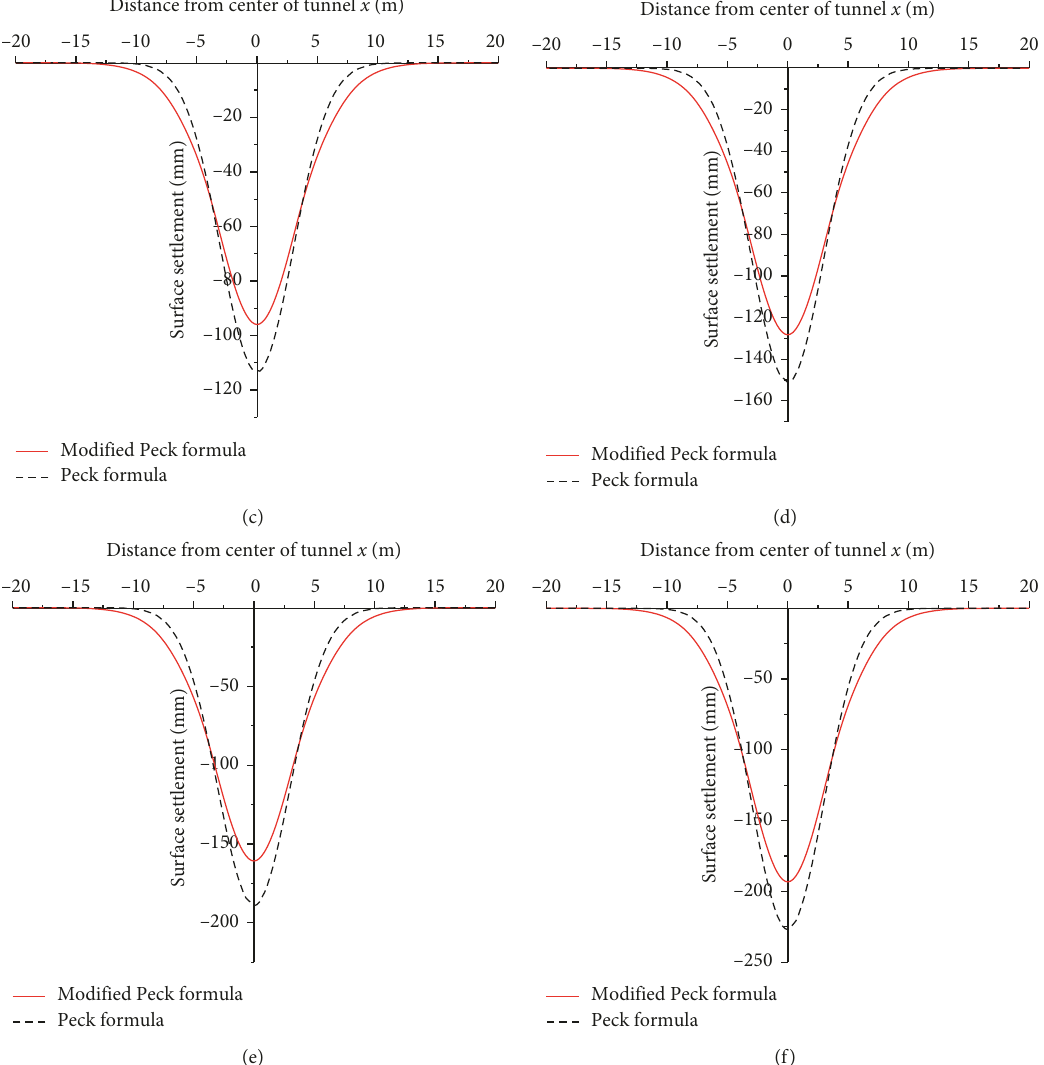
Figure 9: Comparison of calculation results of surface settlement curves for different ground loss rates: (a) v (d) v l � 4%; (e) v l � 5%; (f) v l �